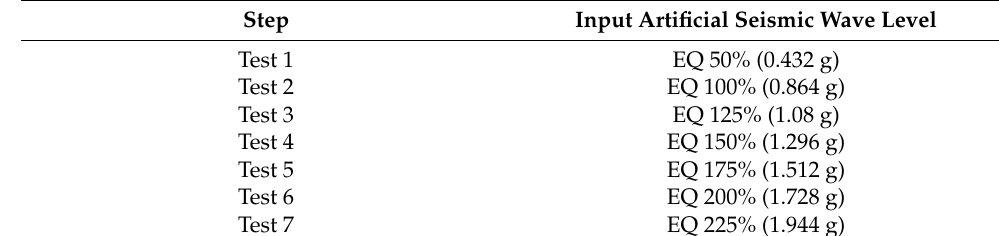
Table 3. Artificial seismic wave level used during the shaking table test.